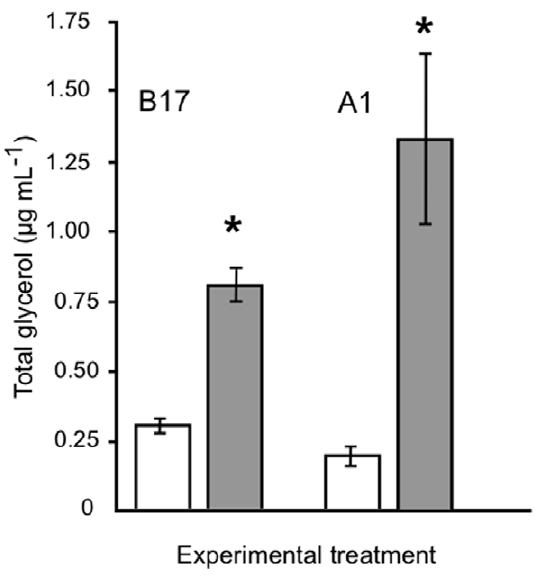
Figure 1. Experimental stimulation of glycerol production in Symbiodinium . Total glycerol ( m g mL 2 1 ) produced by cultured Symbiodinium cells after 1 hr exposure to control conditions (white columns, minus symbol) or with 9% PEG up-shock (gray columns, plus symbol). Values adjusted to 1 6 10 5 cells mL 2 1 . Symbiodinium types indicated on top. Results show the average from 3 independent experiments 6 SD (bars). Significant probabilities (P . 0.05) for comparisons between treatments are shown with an asterisk.